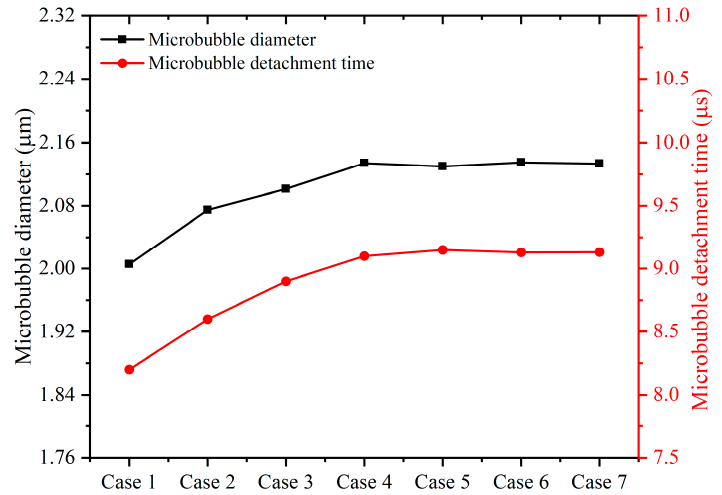
Figure 2. Grid independence test.